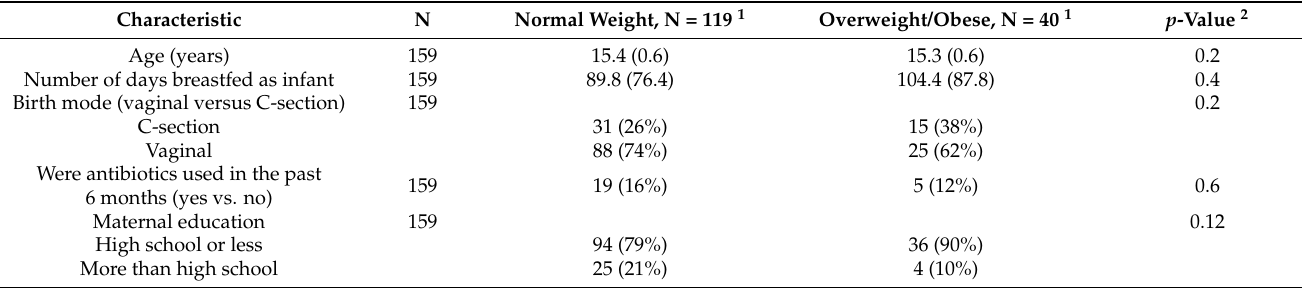
Table 3. Description of the study population from the Growth and Obesity Cohort Study data used in the illustration